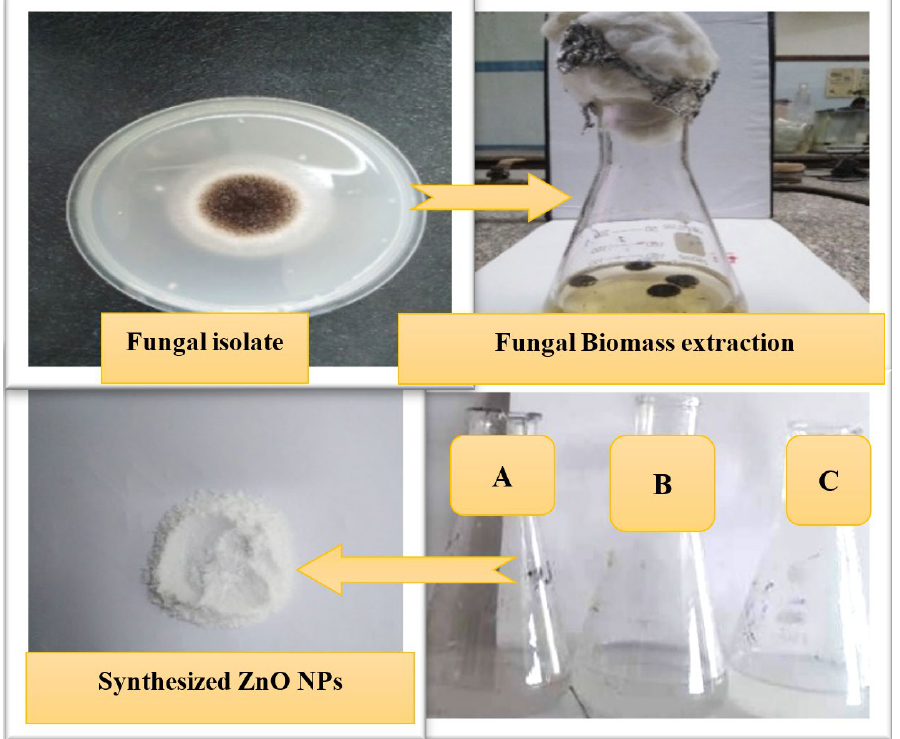
Fig. 3. Scheme for extracellular synthesis of ZnO NPs, (A) fungal biomass extract, (B) Zinc acetate solution and (C) synthesized ZnOPs